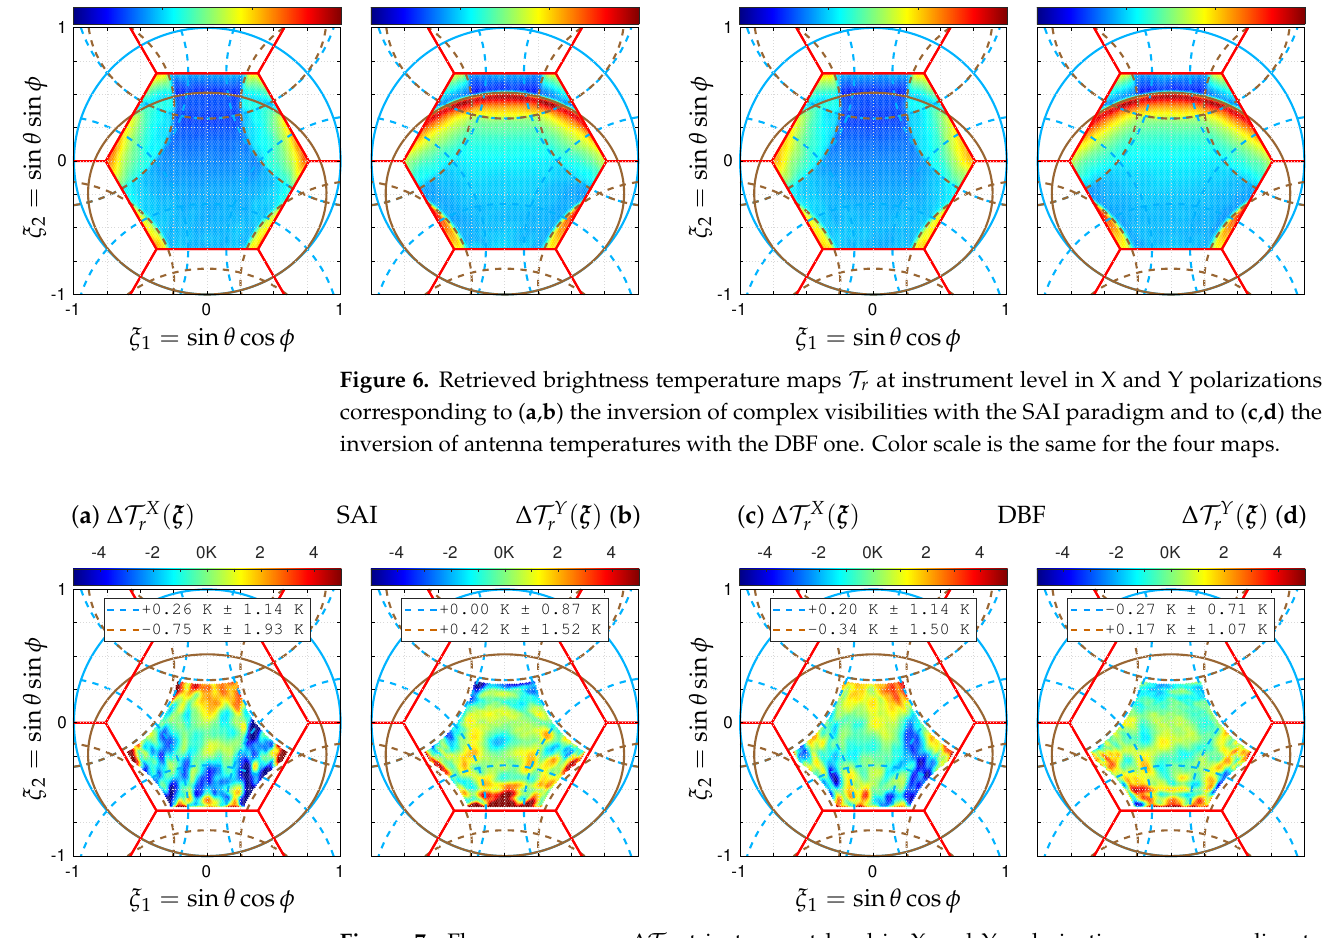
Figure 7. Floor error maps ∆ T r at instrument level in X and Y polarizations corresponding to ( a , b ) the inversion of complex visibilities with the SAI paradigm and to ( c , d ) the inversion of antenna temperatures with the DBF one. Biases and standard deviations are given in the AF-FOV (dashed blue) and in the EAF-FOV (dashed brown). Color scale is the same for the four